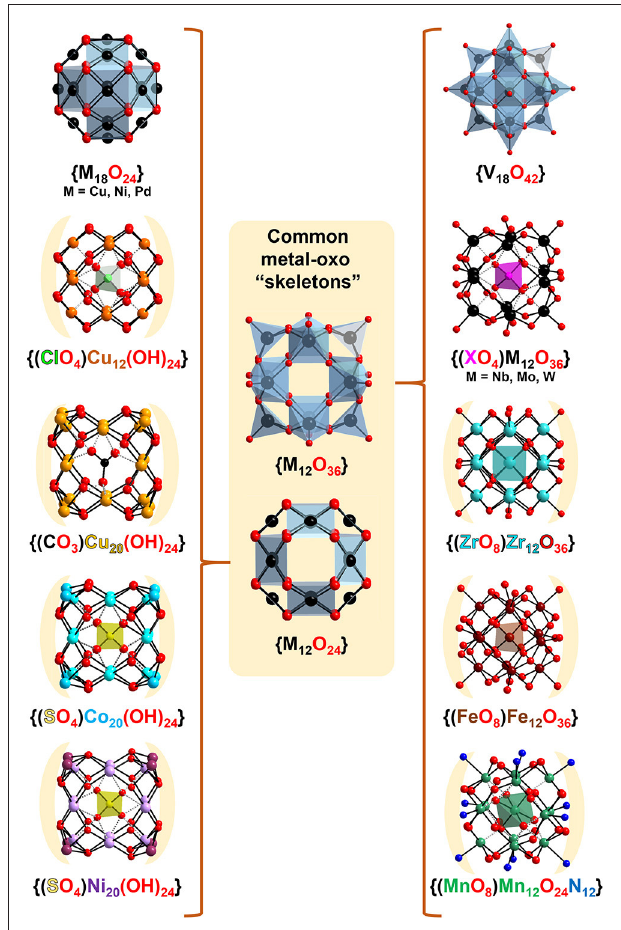
FIGURE 2 | Ball-and-stick representation of the common {M 12 O 36 }/{M 12 O 24 } “skeletons” presented in the classical Keggin structure (Mo and W) and among the other transition metal based Kegginoids: V ( Müller and Döring, 1991 ), Cu (Kondinski and Monakhov, 2017), Fe (Sadeghi et al., 2015), Co (Dong et al., 2013), Mn (Newton et al., 2011), Zr (Day et al., 2005) Ni, and Pd ( Crooks and Weller, 1997; Dong et al., 2009).